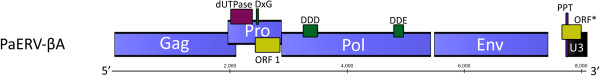
A schematic representation of PaERV-βA. Two transcripts were identified in the P. alecto Illumina sequenced transcriptome that overlapped by 3,152 nt with 100% sequence identity which were used to assemble the PaERV-βA genomic sequence. Indicated are the retroviral genes gag, pro, pol, and env, which have been rendered defective by random mutation since integration. Also shown are the key enzymatic active sites of the viral protease (D×G), reverse transcriptase (DDD), and integrase (DDE); the betaretroviral dUTPase domain in pro; two unique open reading frames (ORFs); the polypurine tract (PPT); and the (Unique 3') (U3) region. ORF* does not appear to be genuine, but rather has arisen as a result of an insertion mutation that has disrupted a stop codon.